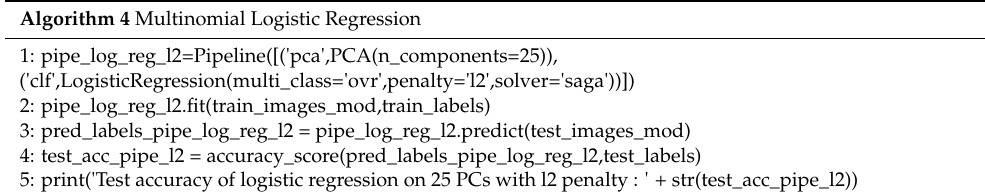
Algorithm 4 Multinomial Logistic Regression